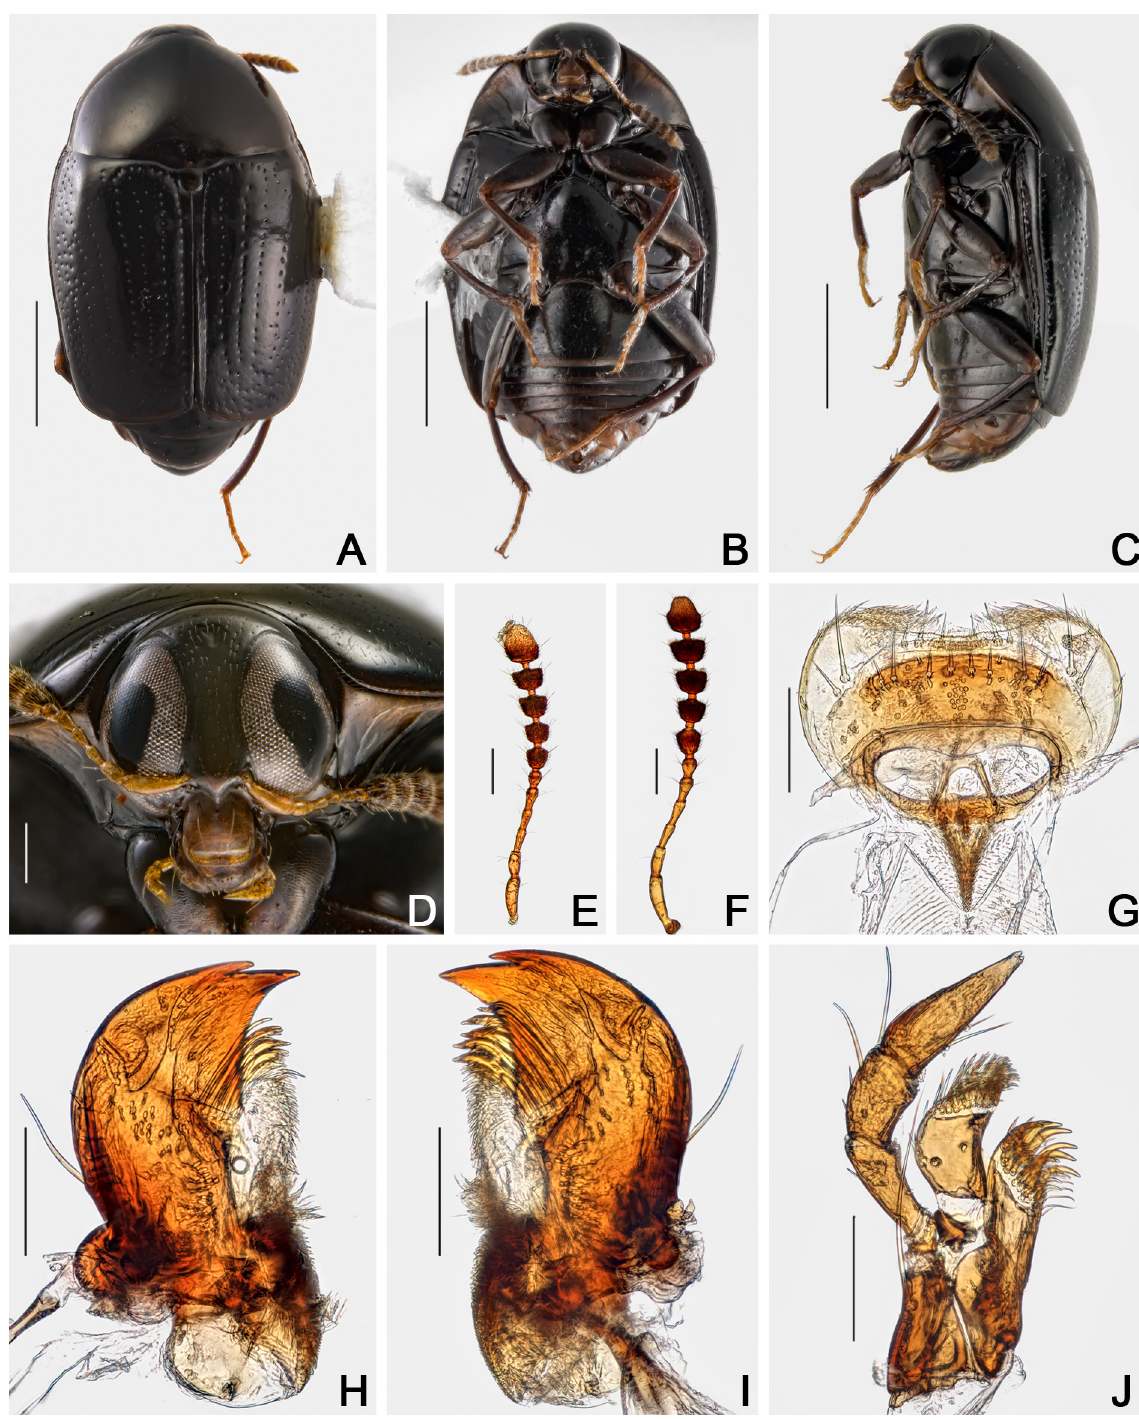
Fig. 7. Cyparium achardi sp. nov. A–D . Holotype, ♂ (CELC). A . Dorsal view. B . Ventral view. C . Lateral view. D . Frontal view. E–F . Antennae, paratype, ♂ (CELC) (E) and paratype, ♀ (CELC) (F). G–J . Paratype, ♂ (CELC). G . Labrum. H–I . Mandible. H . Left. I . Right. J . Maxilla. Specimens collected at Mata do Paraíso, Viçosa (MG, Brazil). Scale bars: A–C = 1.0 mm; D–F = 0.2 mm; G–J =